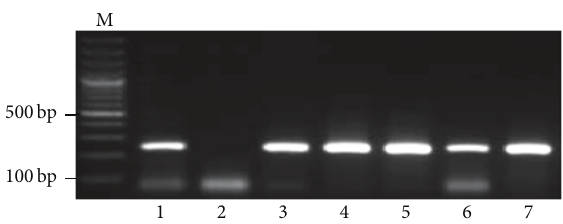
Figure 2: A representative 1.5% agarose gel of PCR products for the detection of HBV in HCV positive patients. Lane M: DNA marker, lane 1: positive control (242 bp), lane 2: negative control, and lanes 3 to 7: patients positive for HBV DNA.